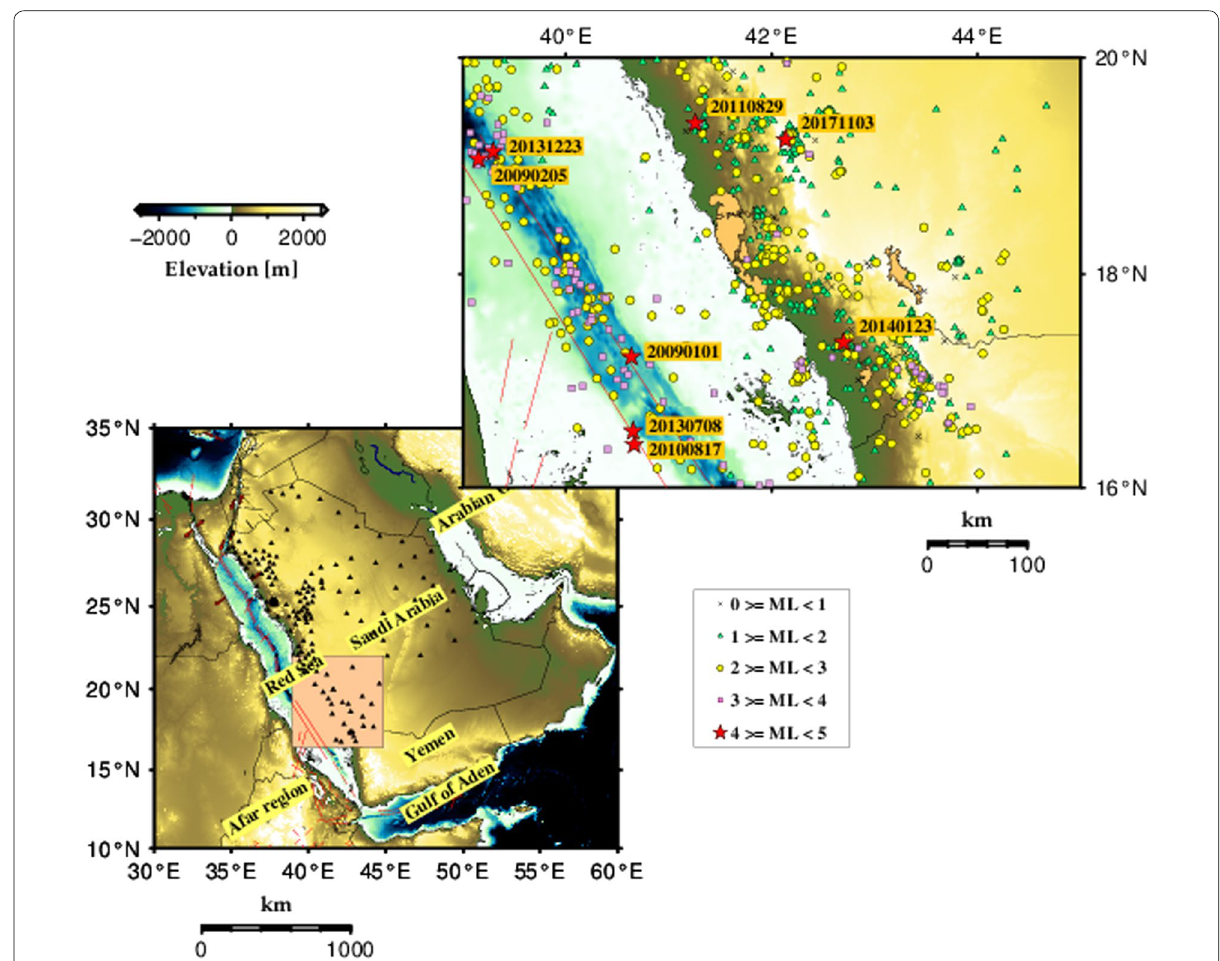
Fig. 1 Map showing the tectonic plate boundaries near the epicenter area and the spatial distribution of epicenters from 2002 to 2017 in its vicinity. The polygons (light brown) refer to the wide distribution of ancient Cenozoic basaltic fields that are called